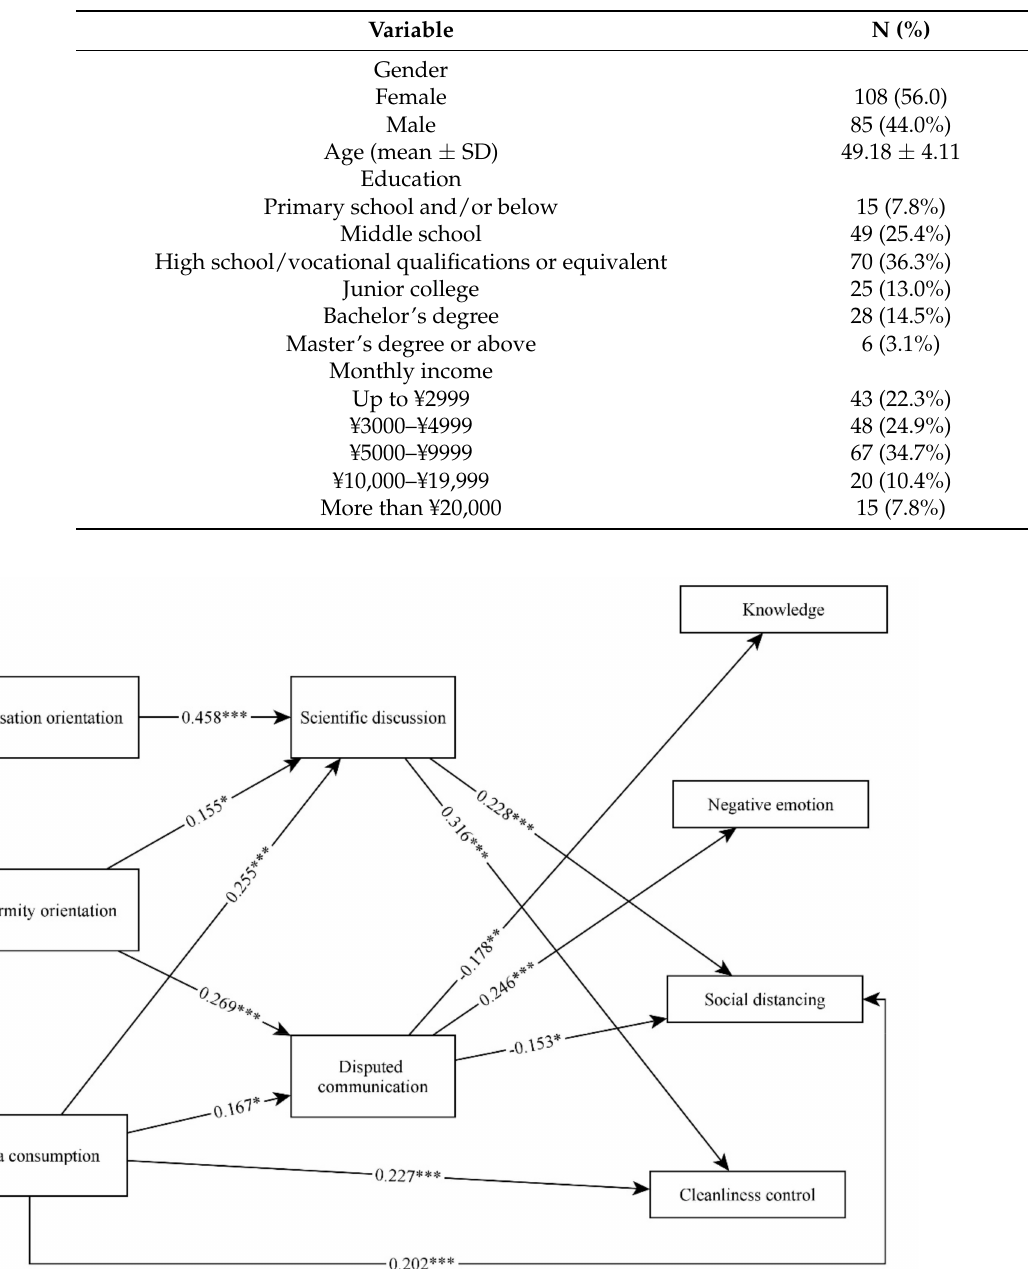
Table 2. Proportions and means of participants.